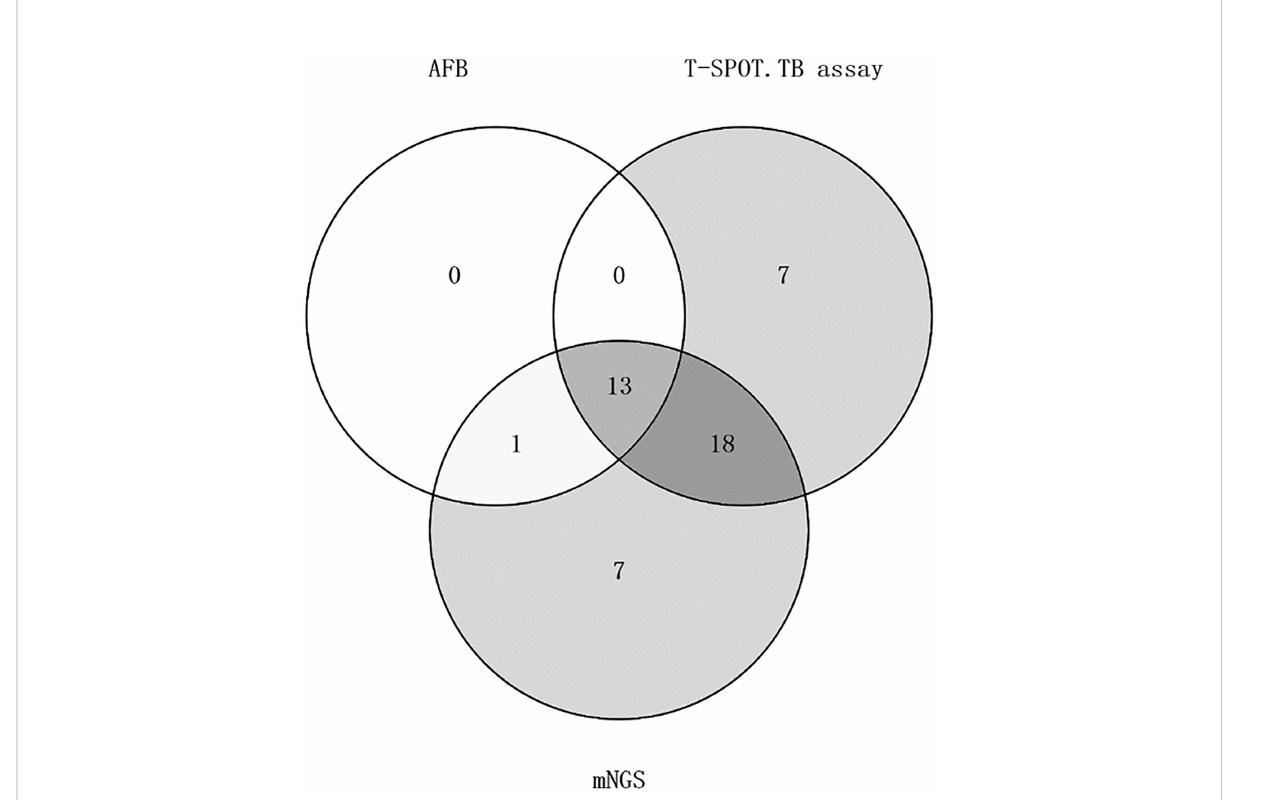
FIGURE 2 Venn diagram of patients with mNGS, acid-fast staining, and the t-spot. TB assay positive